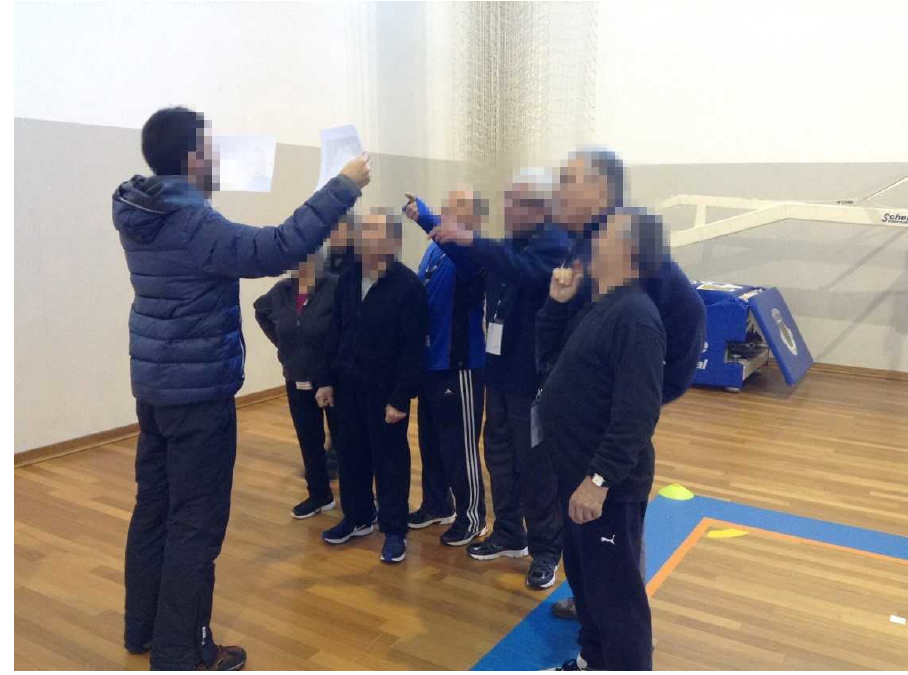
Figure 7. Multiple choice answer (group discussion) during walking exercise. Participants were asked to select, among two, which foods had more sugar, fat, saturated fat, glycemic index, or glycemic load.